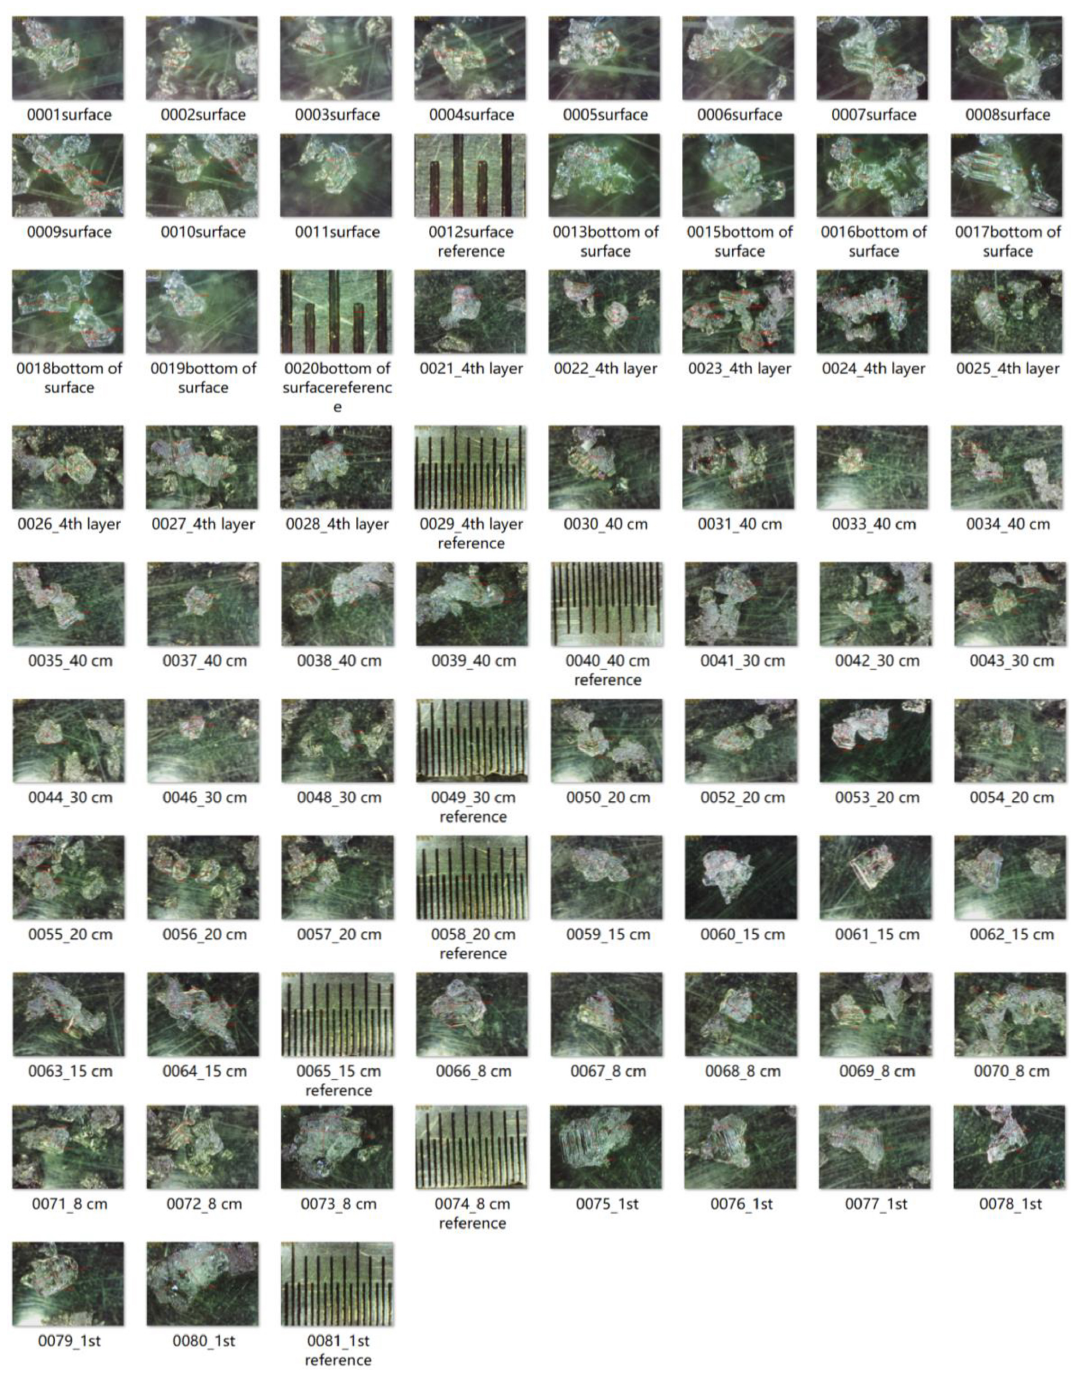
Figure A1. Photos of grains and reference ruler in each layer on 15 February 2016. In each photo the lengths of the longest and shortest axes of the chosen grains are labeled. Original photos are in URL: http://arcticroute.tpdc.ac.cn/navigate/bmp (last access: 8 June 2022).